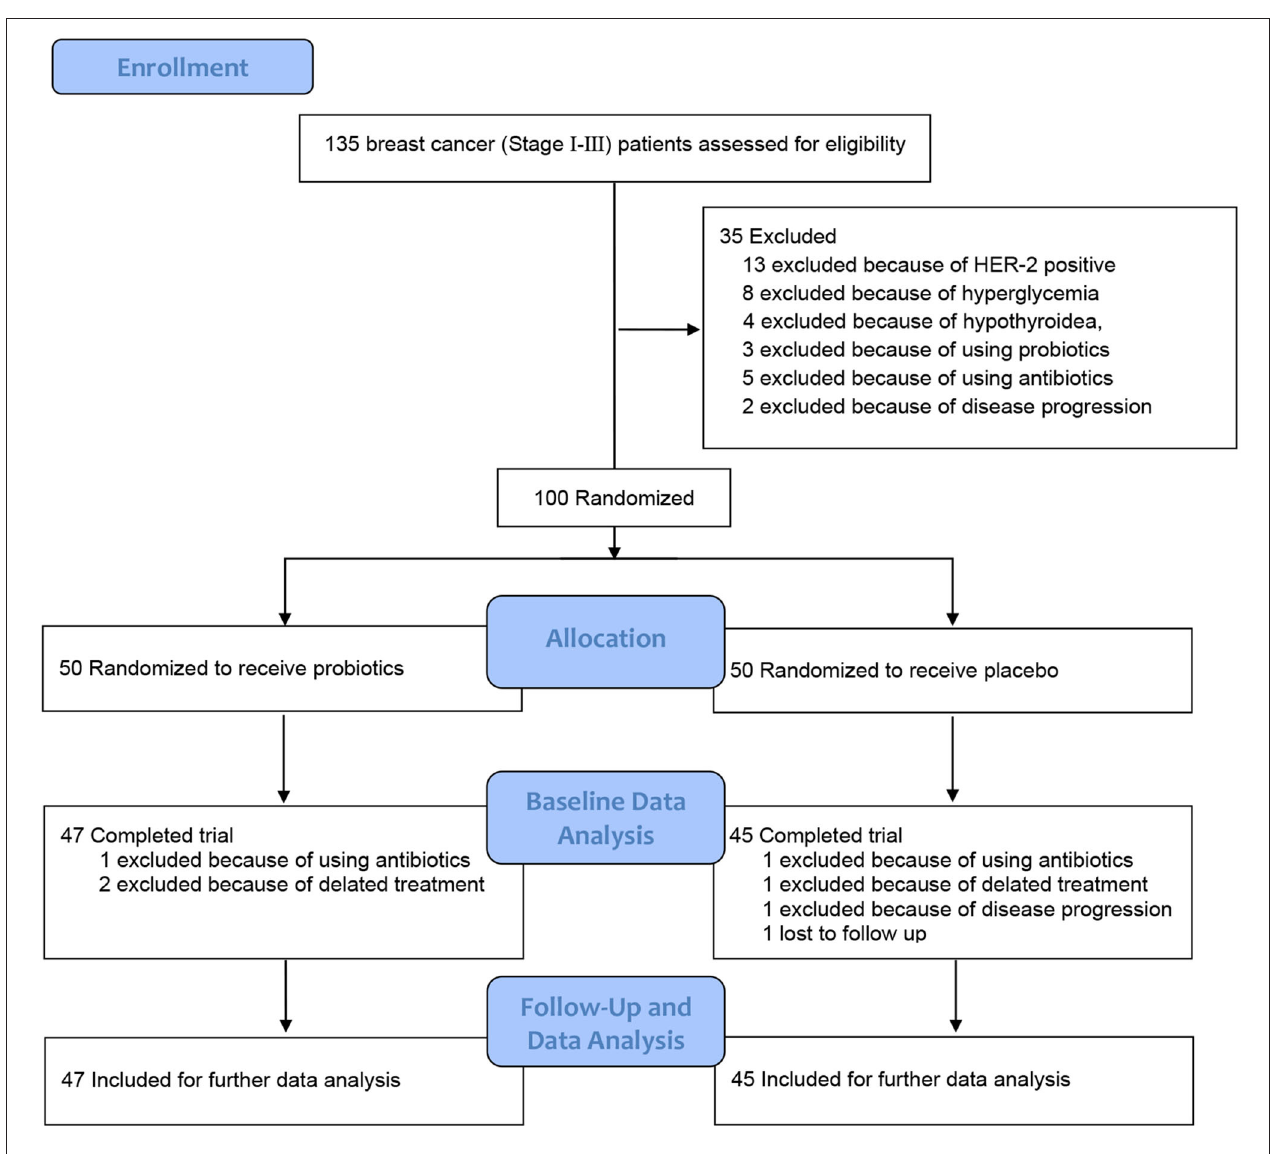
FIGURE 1 | Study flow